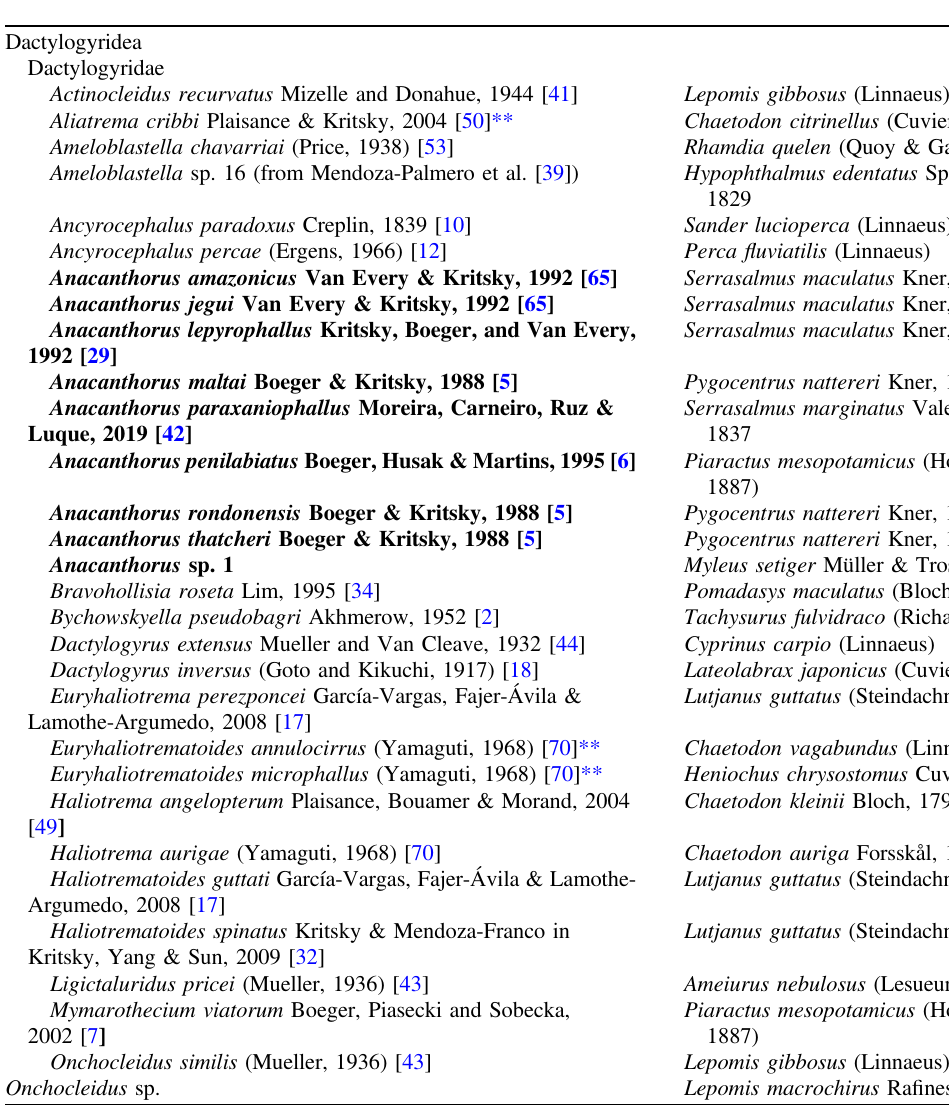
Table 1. Species included in the phylogenetic analyses. Parasite